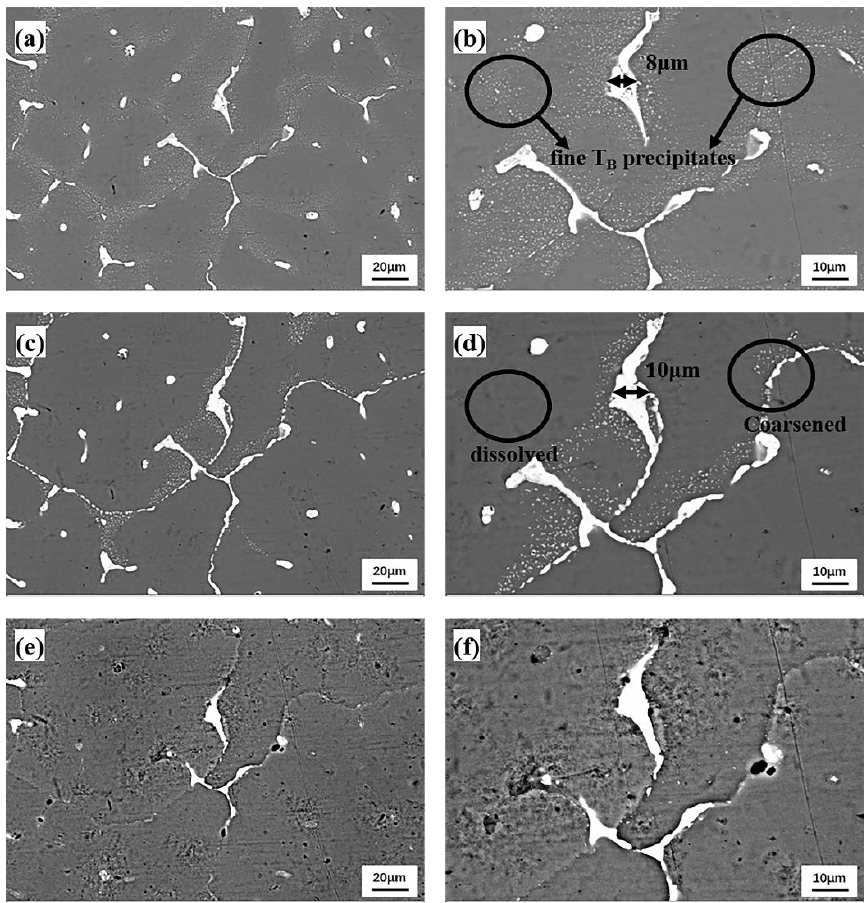
Figure 8. QISOZ backscattered SEM images at 500× ( a , c , e ) and 1000× ( b , d , f ) magnifications at 400 °C ( a , b ), 450 °C ( c , d ) and 500 °C ( e , f ).